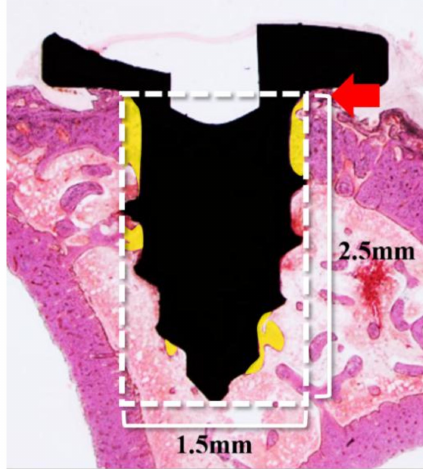
Figure 11. Parameters measured in the bone-to-implant contact (BIC) in histologic analysis. White box; Region of interest (ROI). Red arrow: the end of the implant head; Yellow area: calculated region within